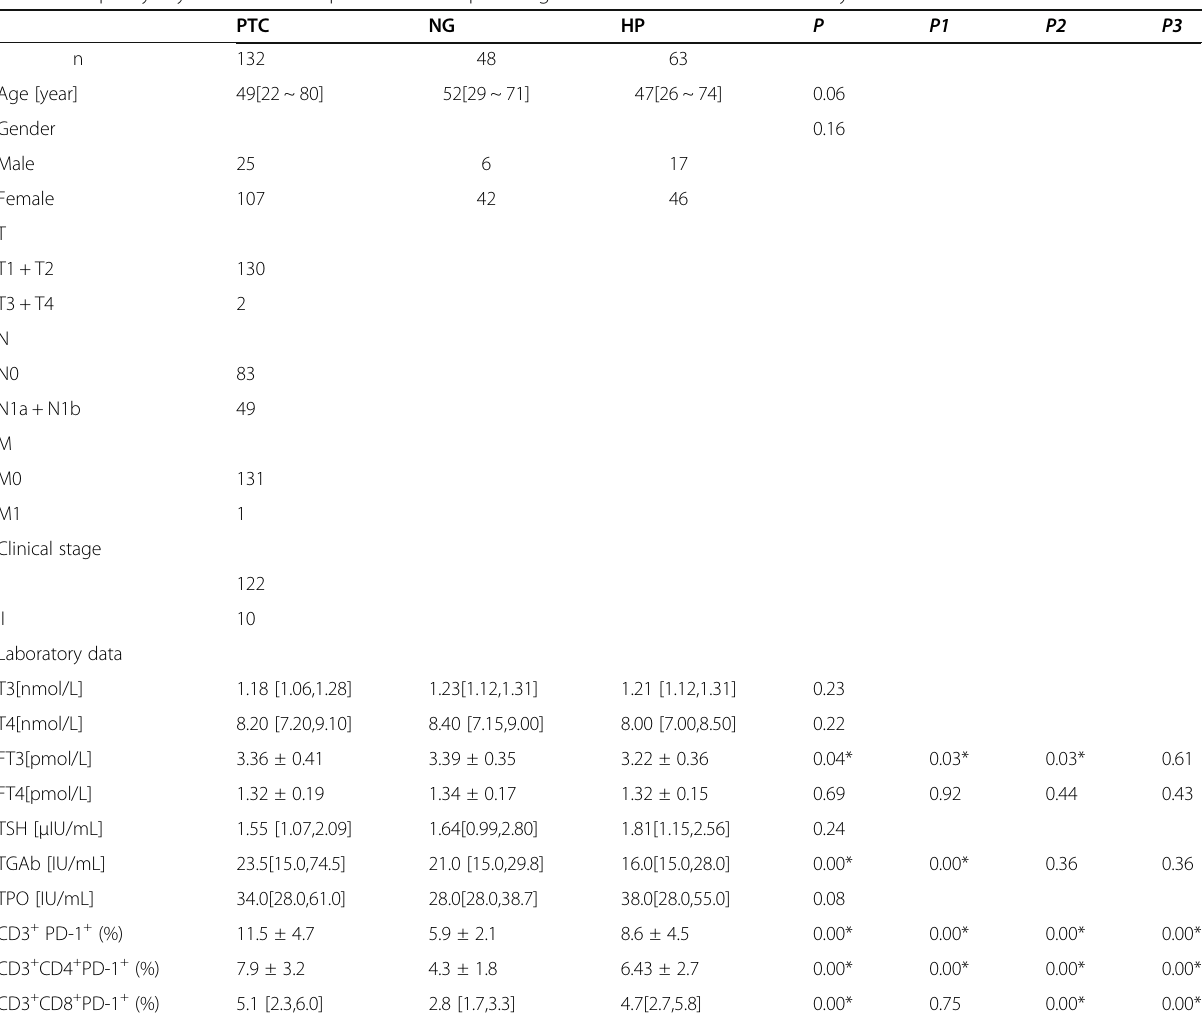
Table 1 Papillary thyroid carcinoma patients ’ clinicopathological characteristics and laboratory